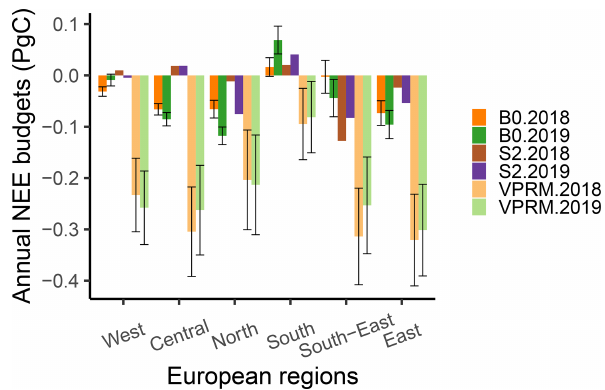
Figure 13. Posterior NEE flux budgets over six European regions in 2018 and 2019 using the B0 and S2 inversions (dark colours) compared to their priors from the VPRM model (light colours). Un- certainties associated with B0 and VPRM fluxes are referred to in the error